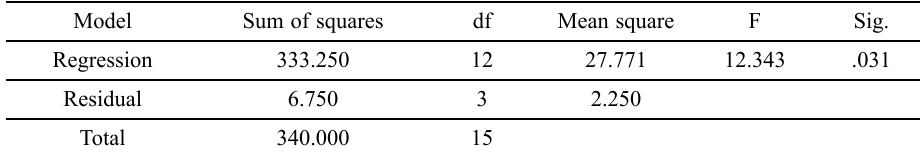
Table 4. ANOVA results of conjoint